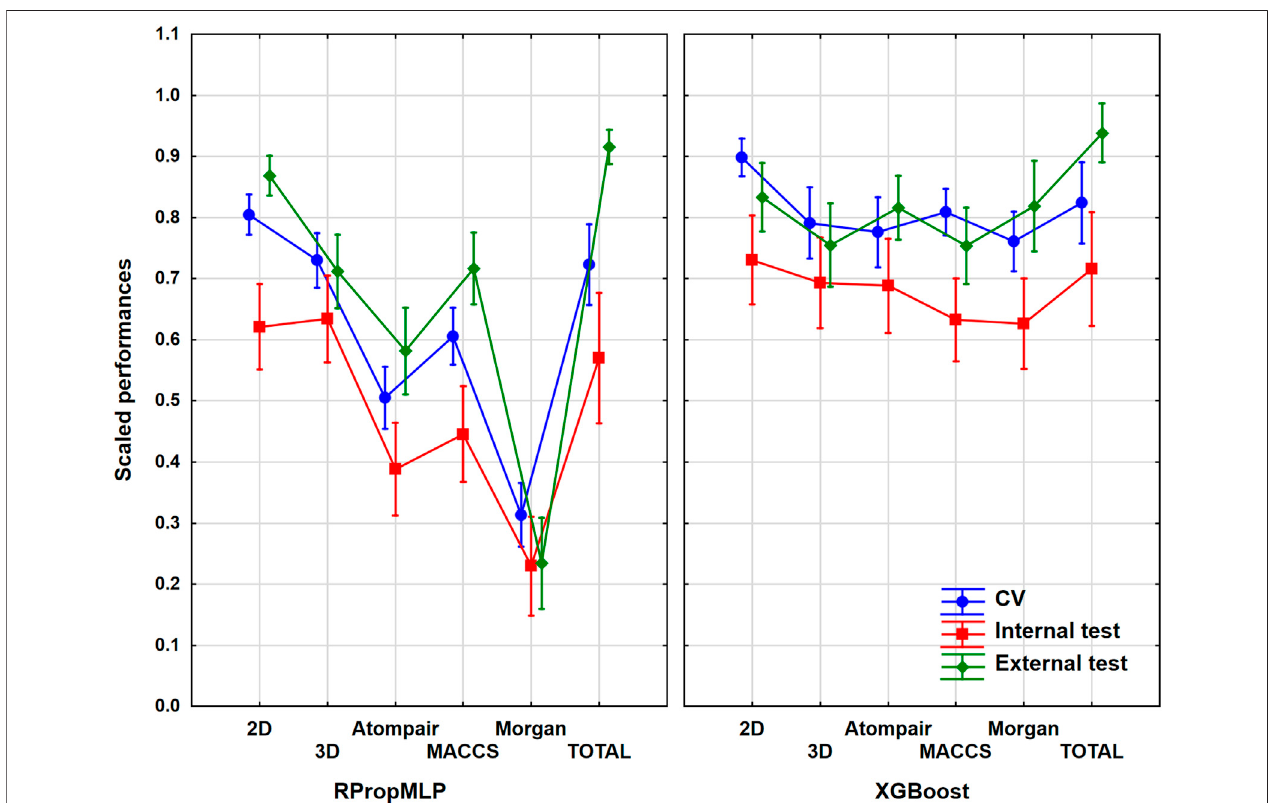
FIGURE 2 | Plot of the scaled performances based on the different molecular descriptor types and different machine learning algorithms. The 18 performance parameterswererange-scaledbetween0and1andaveragedacrossallmodelswiththegivendescriptortypes/MLalgorithms.TheresultofCVismarkedwithblue,the internal test result ismarked with red, and the external is marked with green. The average scaled performance is plotted in each case with the 95% con fi dence intervals.